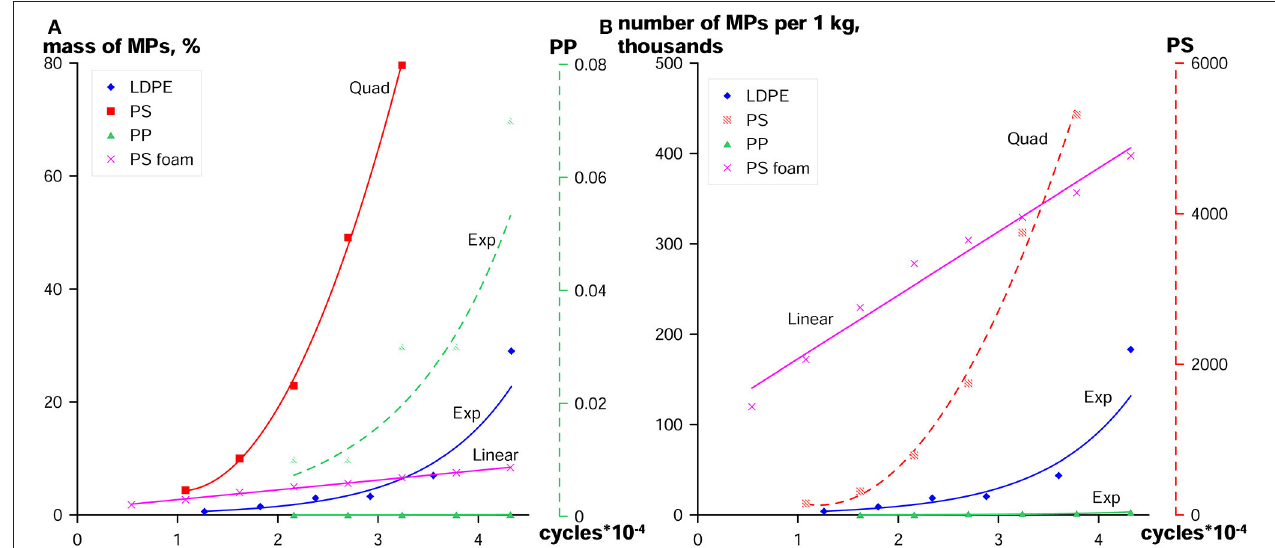
FIGURE 6 | Dependence of (A) mass (in per cent of the total mass of the given plastic) and (B) number of MPs particles, generated from 1kg of LPIs, on the number of “wave periods.” Analogously to Figure 5 , additional axes at the right-hand side, the dashed graphs, and pale markers show: (A) enlarged exponential best fit for the mass of PP MPs; data and graph at the same scale with other plastics are shown by green triangular markers / solid line; (B) best fit for the number of solid PS MPs at much compressed scale.